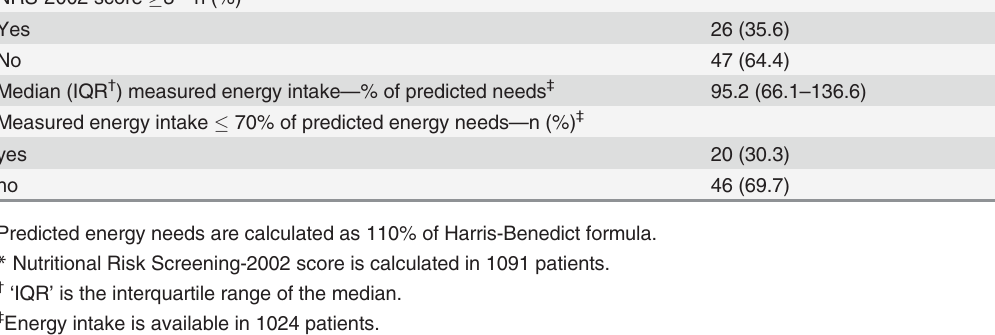
Table 2. Nutritional Risk Screening (NRS)-2002 score and measured energy intake, according to the presence or absence of healthcare-associat- ed infections (HCAI). Variables Presence of HCAI Absence of